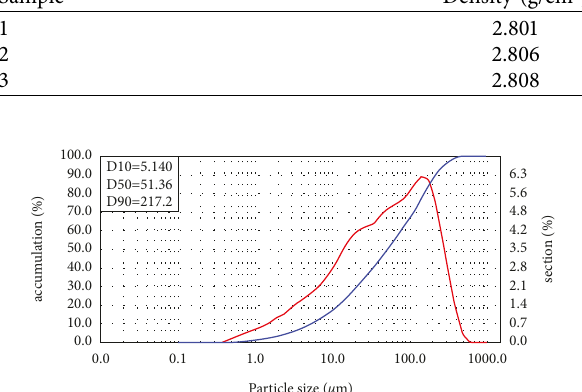
Table 1: Determination of density of the sample at 20 ° C. Sample